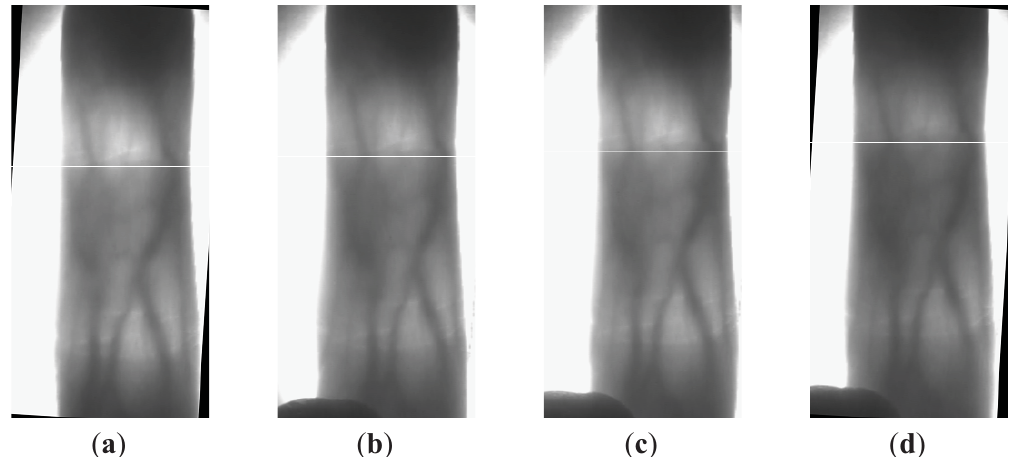
Figure 3. Locations of the distal inter-phalangeal joint in different images of one finger.